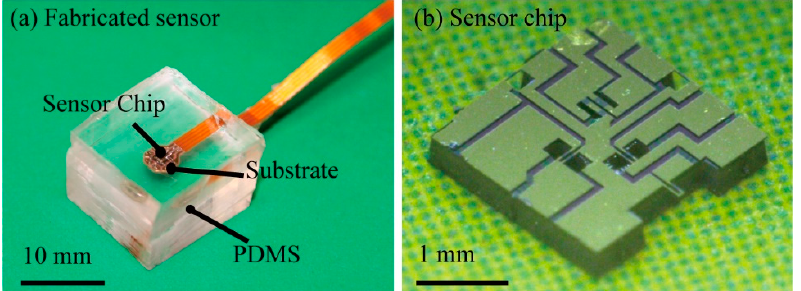
Figure 8. Photograph of the fabricated sensor. ( a ) whole image of the fabricated sensor and ( b ) sensor chip.